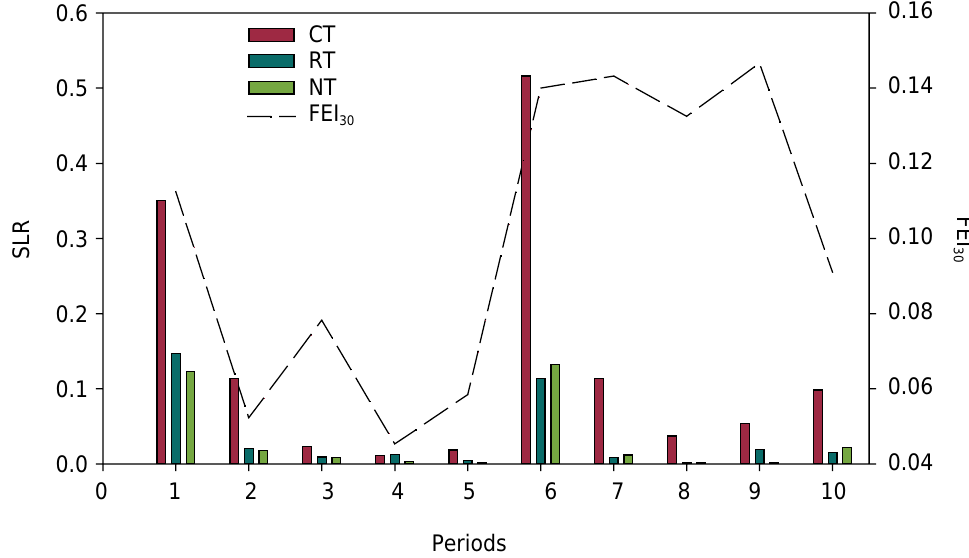
Figure 2. Soil Loss Ratio (SLR) and Fraction Erosivity Index (FEI 30 ) in the different periods and management systems for wheat-soybean succession.